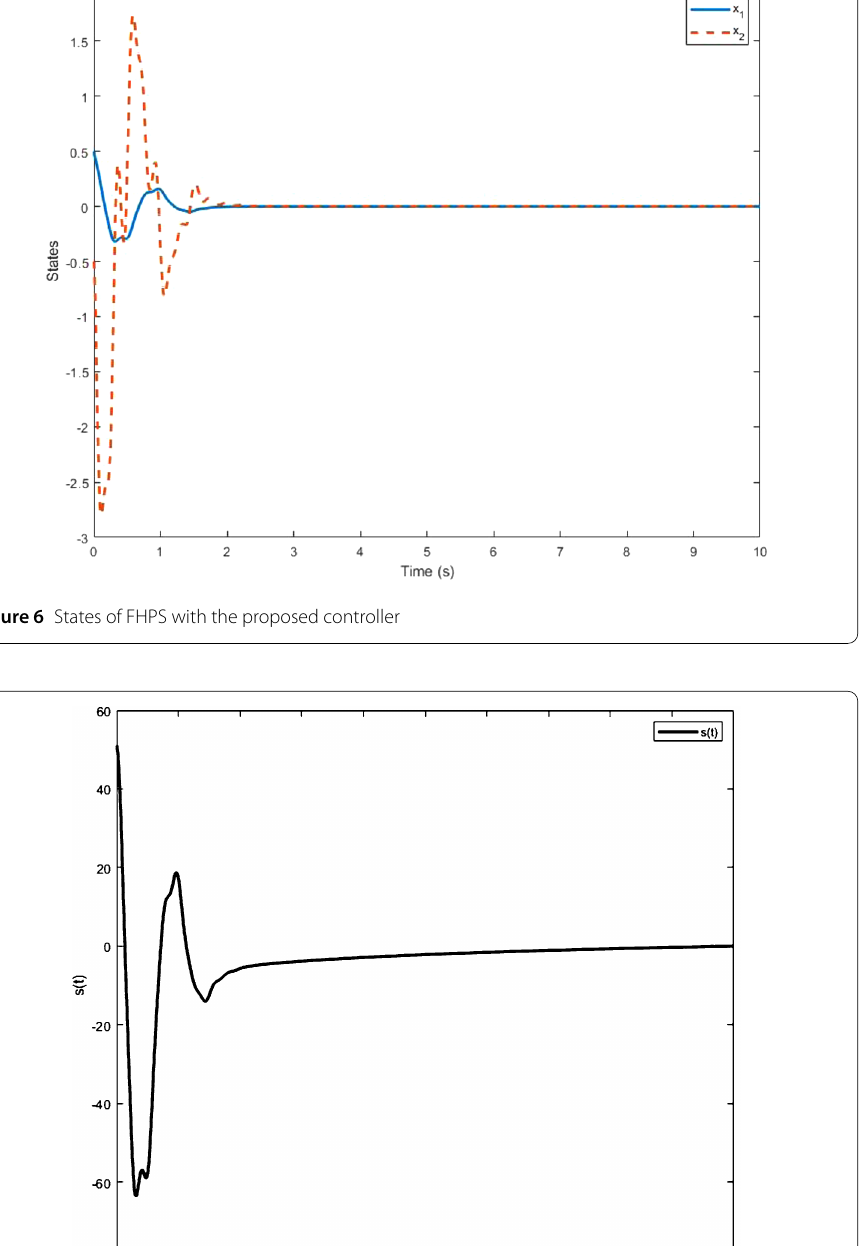
systems, in canonical forms, is considered in this paper. Owing to the existence of satura- tion phenomenon in practice, the influence of unknown saturating functions in the control signal is taken into account. On the other hand, due to the complex and uncertain dynam- ics of the recent applied fractional dynamical systems, it is assumed that the dynamics of the system is fully unknown and the system is subject to external noise and model